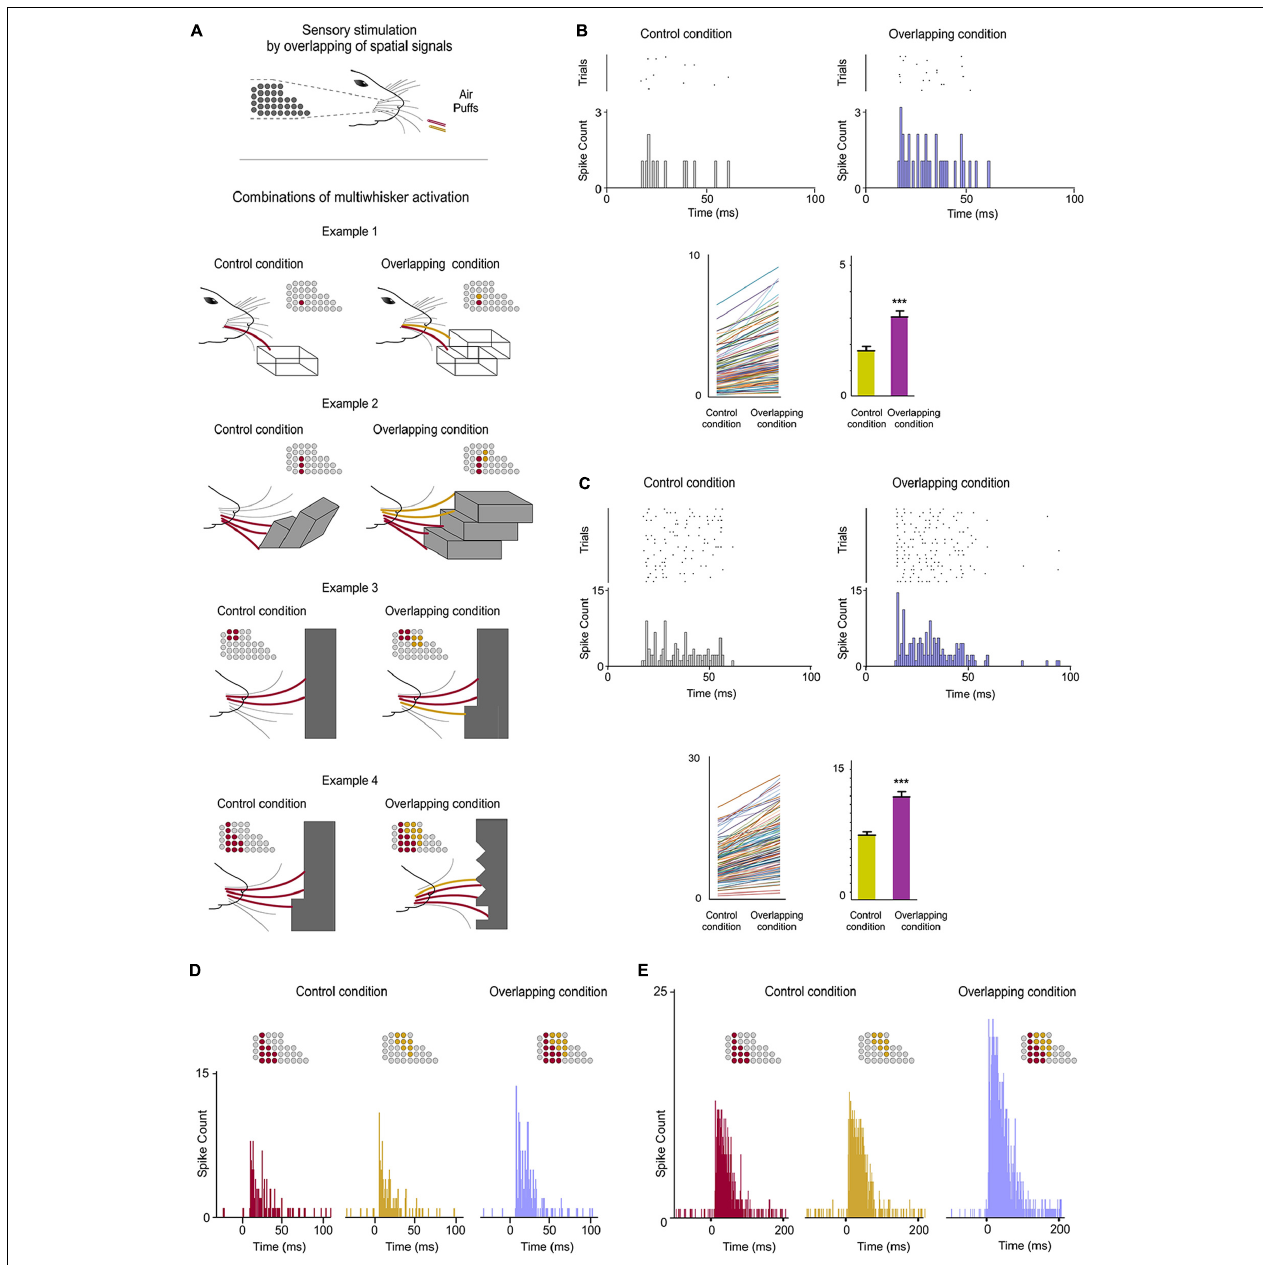
FIGURE 3 | POm integration of spatial signals. (A) Sensory stimulation was produced by the application of individual (Control Condition) or simultaneous air puffs (Overlapping Condition) activating different whiskers and producing diverse combinations of multiwhisker activation. The number of whiskers stimulated by each air puff was varied to generate different combinations. They were repeated multiple times (range 20–70 repeats) and POm responses to them were studied and quantified by comparison between Control and Overlapping conditions. Four examples of these combinations are shown. The whiskers stimulated are depicted in different colors in the schematic representations of the whisker pads. Simulated objects and surfaces are only shown to illustrate similar real overlappings. (B) POm response magnitude increased when whiskers were activated simultaneously as can be appreciated in the peri-stimulus time raster plots and histograms of a representative POm single-unit response for 20 trials evoked by the example 2 in panel (A) . Data comparing the spike rate in Control and Overlapping conditions of single-units ( n = 102, depicted in different colors) across stimulation combinations and the total mean response magnitude in both conditions are also shown. The mean firing rate of all single-units was significantly increased in the Overlapiing condition (72%; p < 0.001; Wilcoxon matched-pairs test). (C) Same as in panel (B) , but for multi-unit activity. Raster plots and PSTHs of a demonstrative POm multi-unit response for 40 trials evoked by the example 3 in panel (A) . The spike rate in Control and Overlapping conditions of multi-units ( n = 136, depicted in different colors) across stimulation combinations and the total mean response magnitude in both conditions are shown. The mean firing rate of all multi-units was significantly increased in the Overlapiing condition (56%; p < 0.001; Wilcoxon matched-pairs test). (D) PSTHs of POm single-unit responses evoked by the example 4 in panel (A) (40 trials). To visualize the facilitative integration of overlapping spatial signals, individual evoked responses in the Control Condition are displayed separately. (E) Same as in panel (D) , but for multi-unit activity.